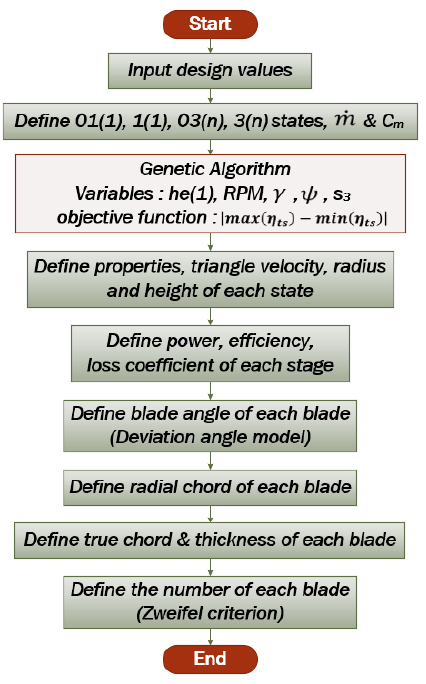
Figure 6. Flow chart of the preliminary design algorithm for a radial outflow turbine.